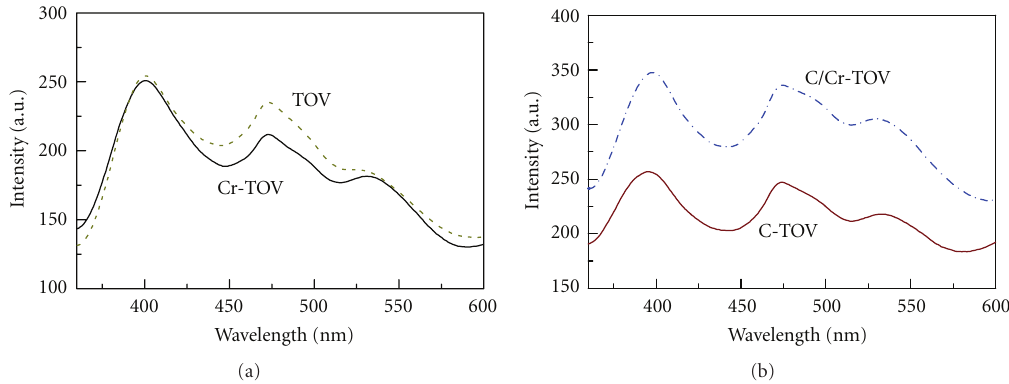
Figure 4: Photoluminescence spectra of samples: (a) TOV and Cr-TOV, (b) C/Cr-TOV and C-TOV at room temperature ( λ ex = 320nm).